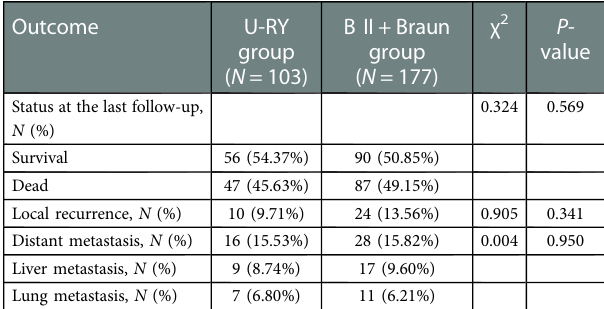
TABLE 4 Comparison of the long-term outcomes of the two groups.